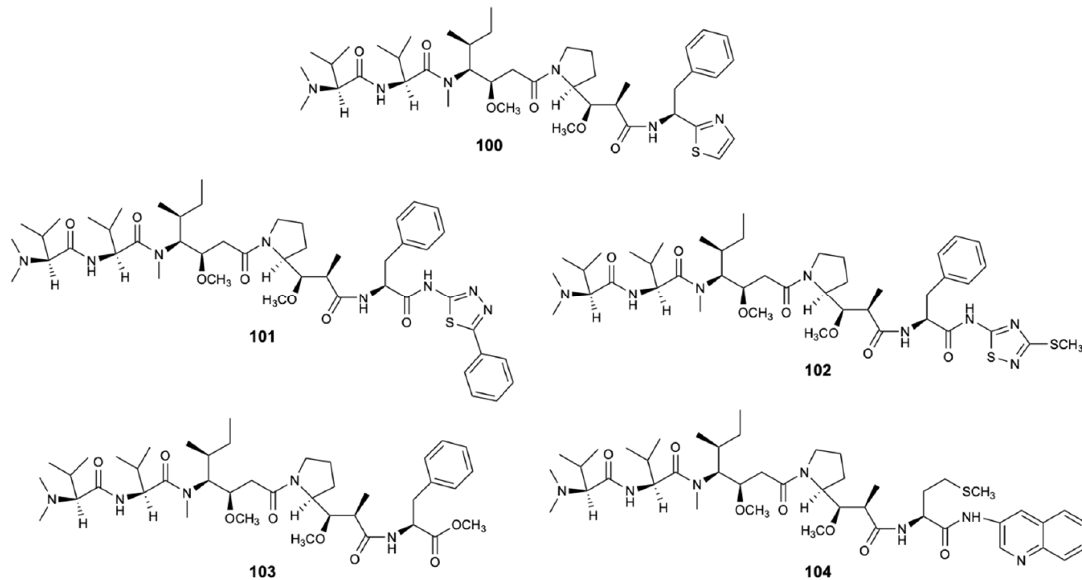
Figure 25. Structures of dolastatin 10 ( 100 ) and analogues 101 – 104 .